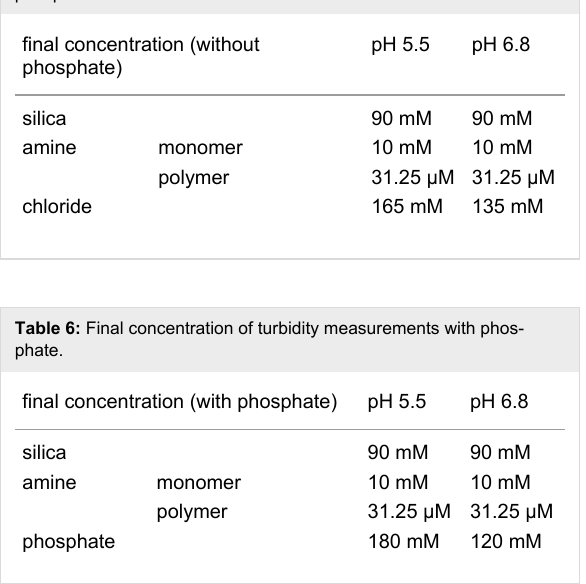
Table 5: Final concentration of turbidity measurement samples without phosphate.